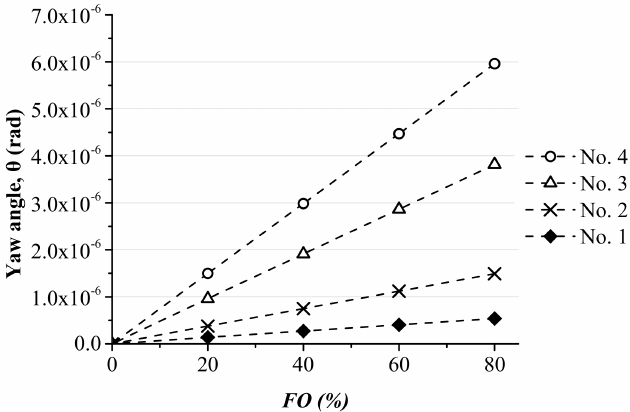
Figure 11. Yaw angle vs. force offset for various